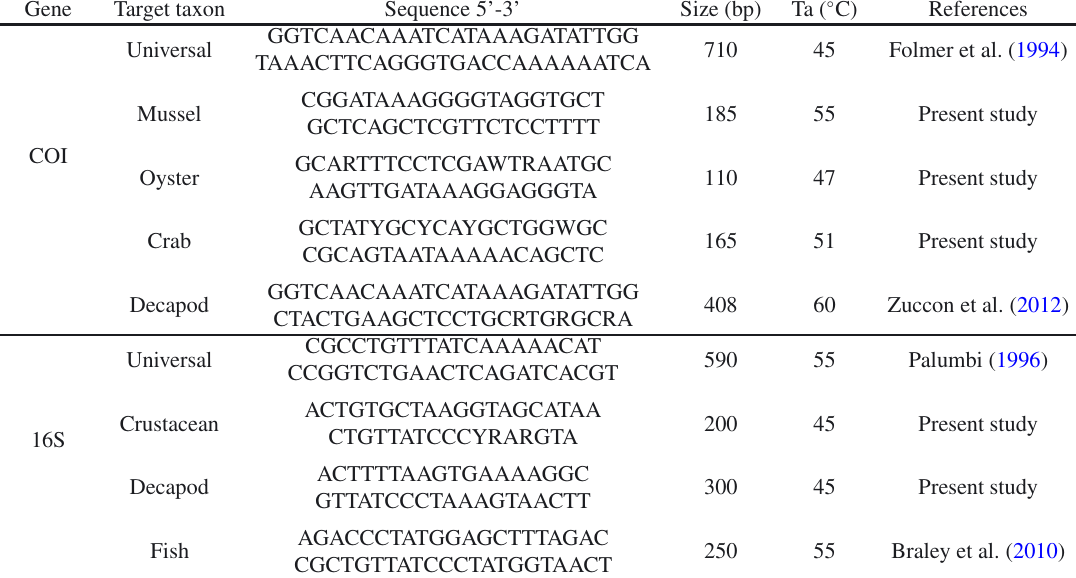
Table 2. Primers used in the study. Annealing temperatures (Ta) are based on the citation reference or designed for the study using gradient